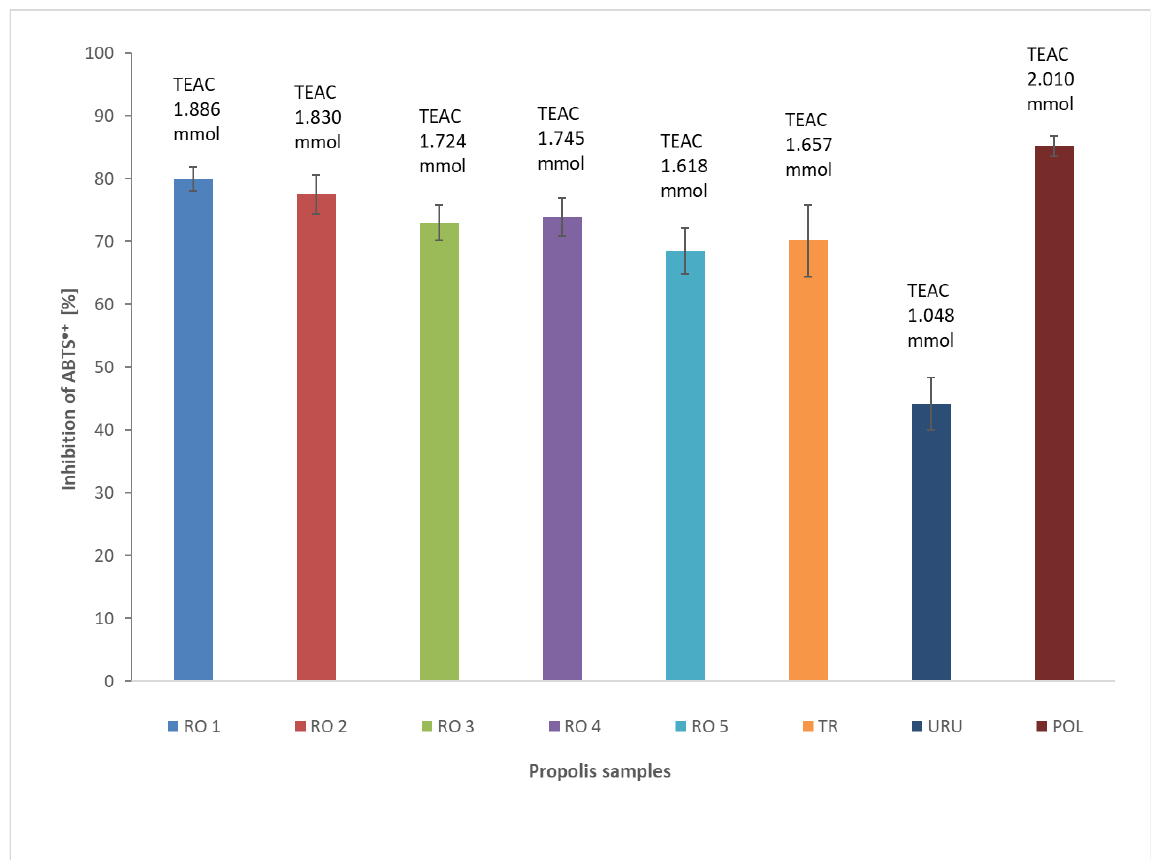
Figure 2. The percentage of ABTS radical cation inhibition at different propolis samples and calculated TEAC values (URU—Uruguayan, TUR—Turkish, POL—Polish, RO 1–5—Romanian). Error bars represent the standard deviation (SD) of the three independent determinations.